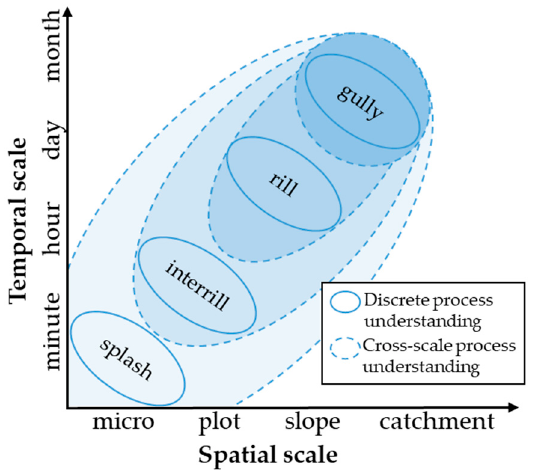
Figure 6. Soil erosion processes considered by taking their cross-scale interaction into account (dashed ellipses) as well as the discrete consideration within their dominant temporal and spatial scale (continuous ellipses). Assessment techniques such as splash cups, discharge measurement, roller chain and topographical survey, as well as process-based soil erosion models, have a discrete process un- derstanding, whereas methods as remote sensing of tracing offer a cross-scale process